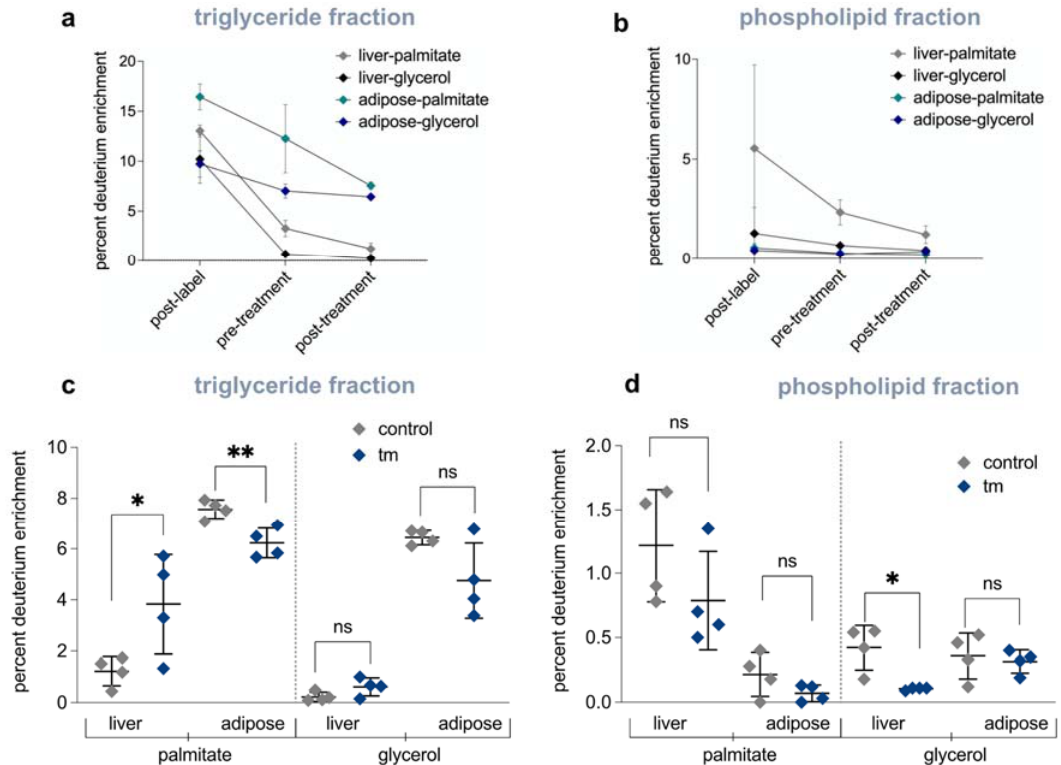
Figure 5. ( a ) Pre-labeling of triglycerides in control (DMSO) mice: percent deuterium enrichment of palmitate incorporated into triglycerides after 7 weeks of deuterium labeling (post-label), after a 2 week label free period (pre-treatment), and post 72 h treatment period ( n = 3 per group). ( b ) Pre-labeling of phospholipids in control (DMSO) mice: percent deuterium enrichment of palmitate incorporated into phospholipids after 7 weeks of deuterium labeling (post-label), after a 2 week label free period (pre-treatment), and post 72 h treatment period ( n = 3 per group). ( c ) Percent deuterium incorporated into palmitate and glycerol of triglycerides found in the liver or adipose after control (DMSO) or 1.5 mg/kg tunicamycin treatment after 72 h ( n = 4 per group). ( d ) Percent deuterium incorporated into palmitate and glycerol of phospholipids found in the liver or adipose after control (DMSO) or 1.5 mg/kg tunicamycin treatment after 72 h ( n = 4 per group). ns = no significance, * = <0.05, ** = <0.01.